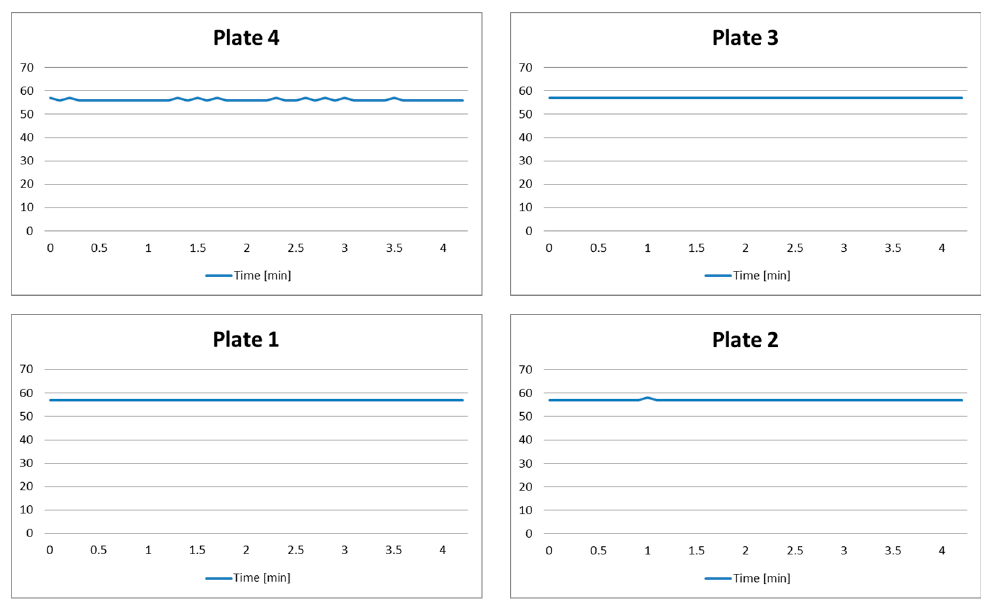
Figure 5. Test results of Scenario 1.